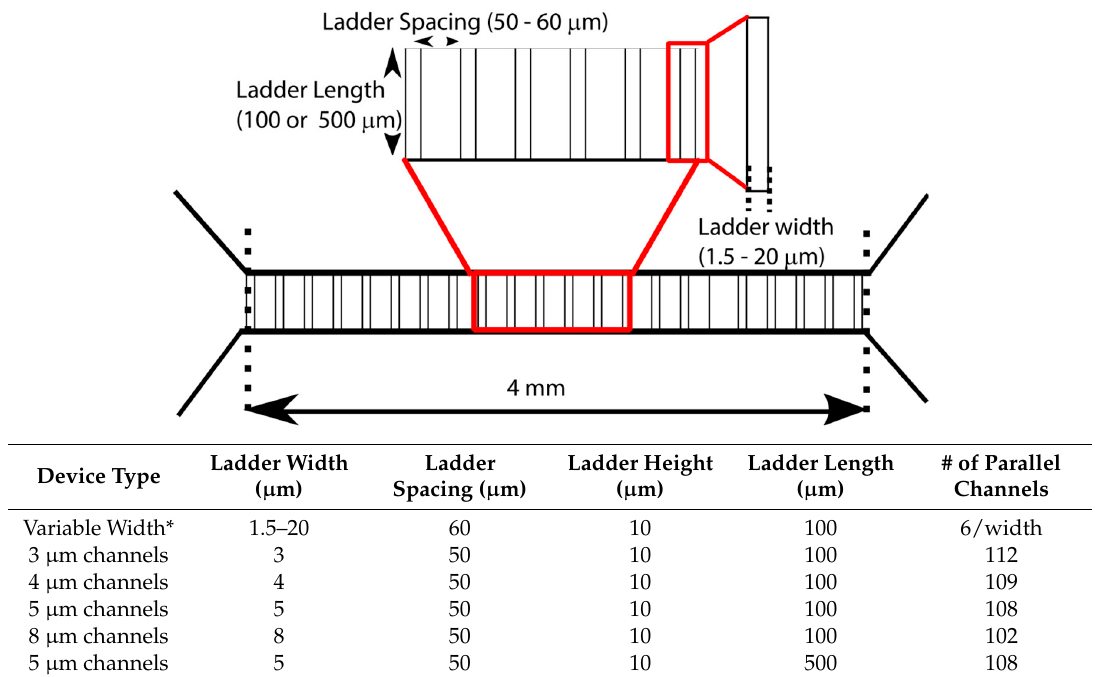
Table 1. Dimensions of the Central Ladder Channels Connecting the Proximal and Distal Chambers.